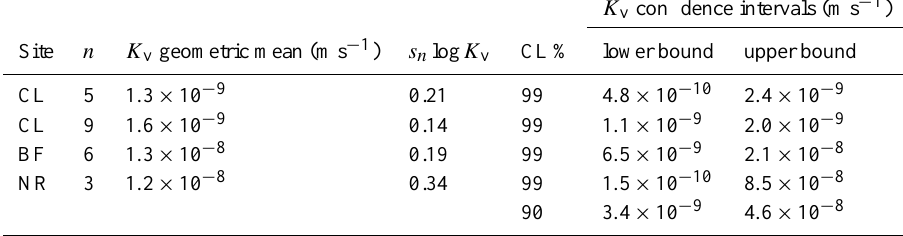
Table 4. Geometric mean, standard deviation ( s n ) and confidence limits (CL%) analysis for K v data using the CP method to test core from the clayey-silt formation at the CL, BF, and NR